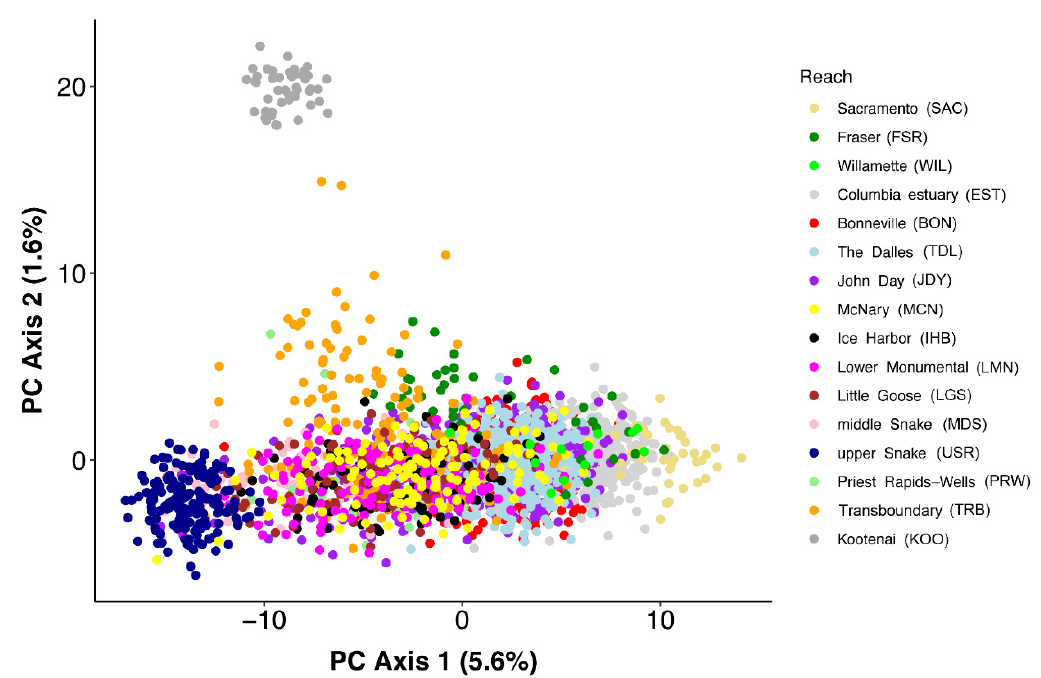
Figure 3. Scatterplot of loadings on the first two axes from principal component analysis of white sturgeon. For each axis, the percentage of genetic variance explained is indicated. Table 3. Values of G”ST of white sturgeon with darker shades reflecting higher values. Values not significant after correction for multiple tests are indicated with